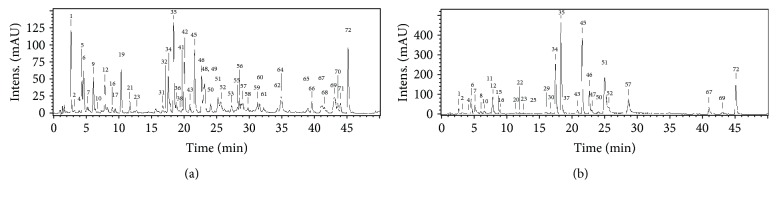
Representative UHPLC chromatograms at 280 nm of (a) DEF and (b) EAF extracts of S. aucuparia flowers. Peak numbers refer to those implemented in Table 1.